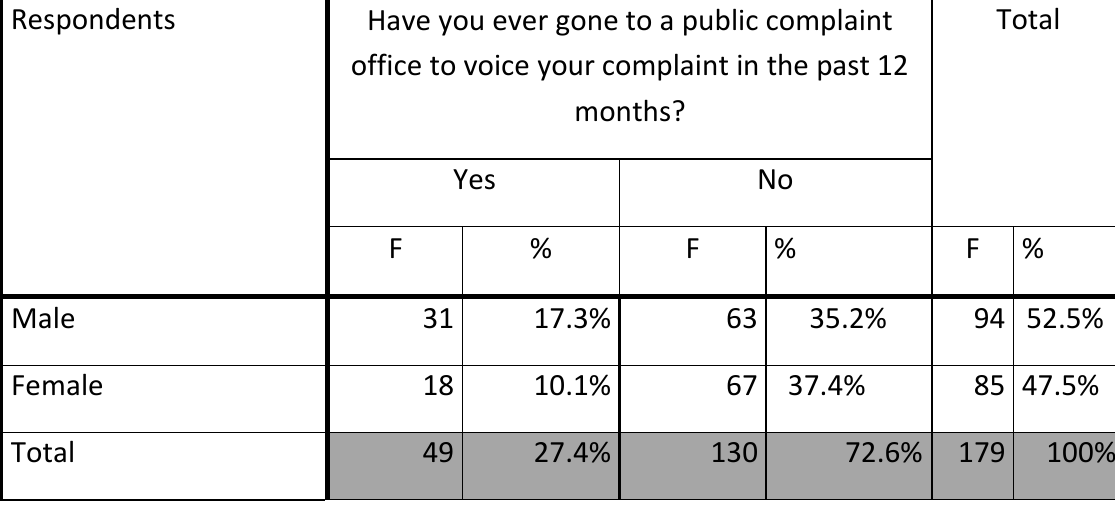
Table 6: Respondents' experience with the public compliant office of the town?